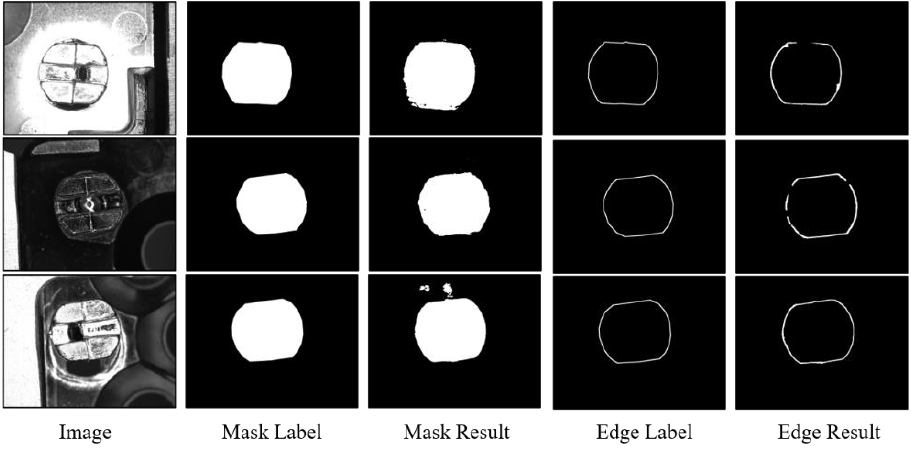
Figure 9. Part of the results of different labels.